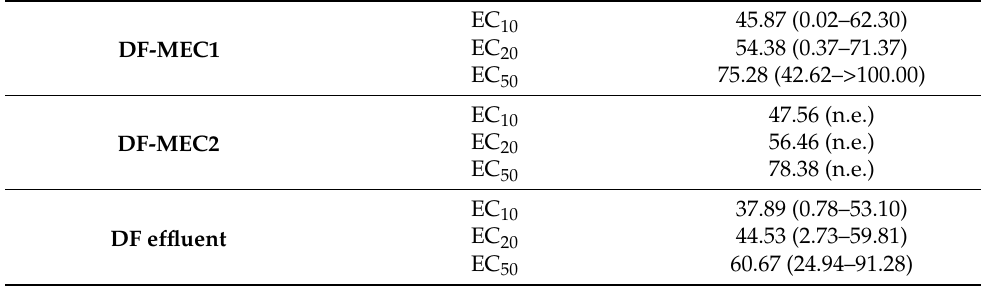
Table 4. Toxic endpoints, in terms of 24 h EC 10, 20 and 50 values (% v / v ) and confidence intervals (lower and upper bound values within parenthesis) in Thamnocephalus platyurus challenged with different concentrations of DF effluent samples, as well as DF-MEC1 and DF-MEC2 effluents, as obtained by Probit analysis ( p < 0.05, N = 3).